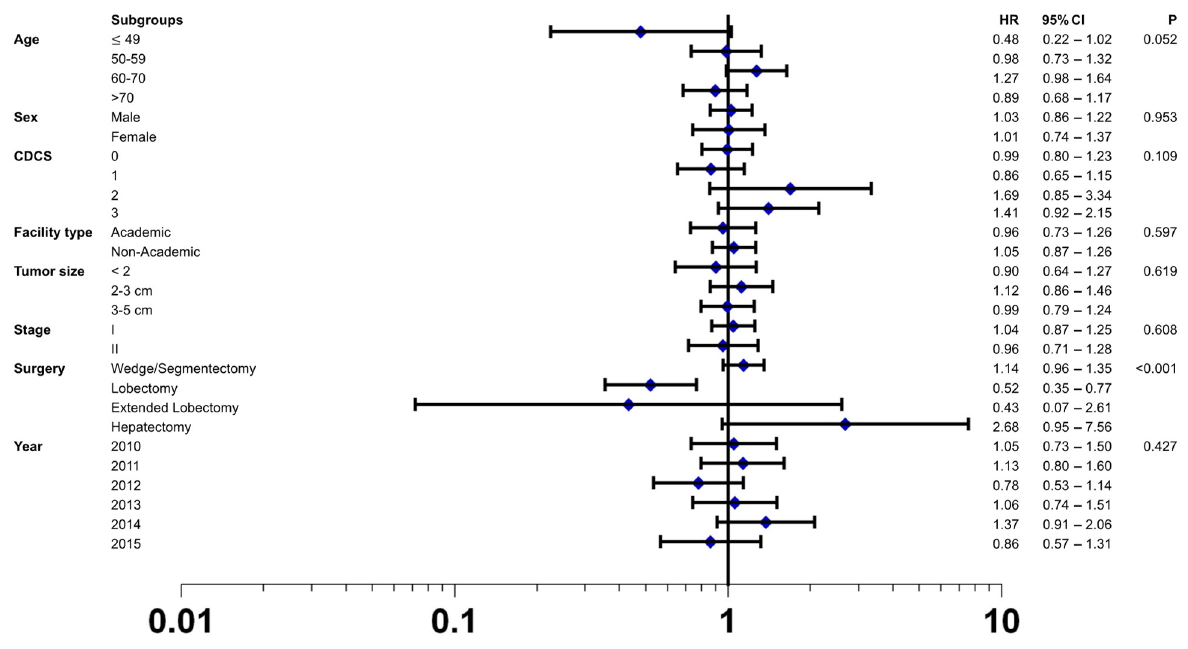
Figure 4. Forest plot depicting hazard ratio of minimally invasive liver resection versus open liver resection in the matched study cohort using the tests of interaction in the following subgroups: age, sex, CDCS (Charlson Deyo Comorbidity Index Score), facility type, tumor size, stage, surgery, and year. The open liver resection group was used as reference. Black squares represent hazard ratios (and 95% confidence intervals by the corresponding horizontal lines).